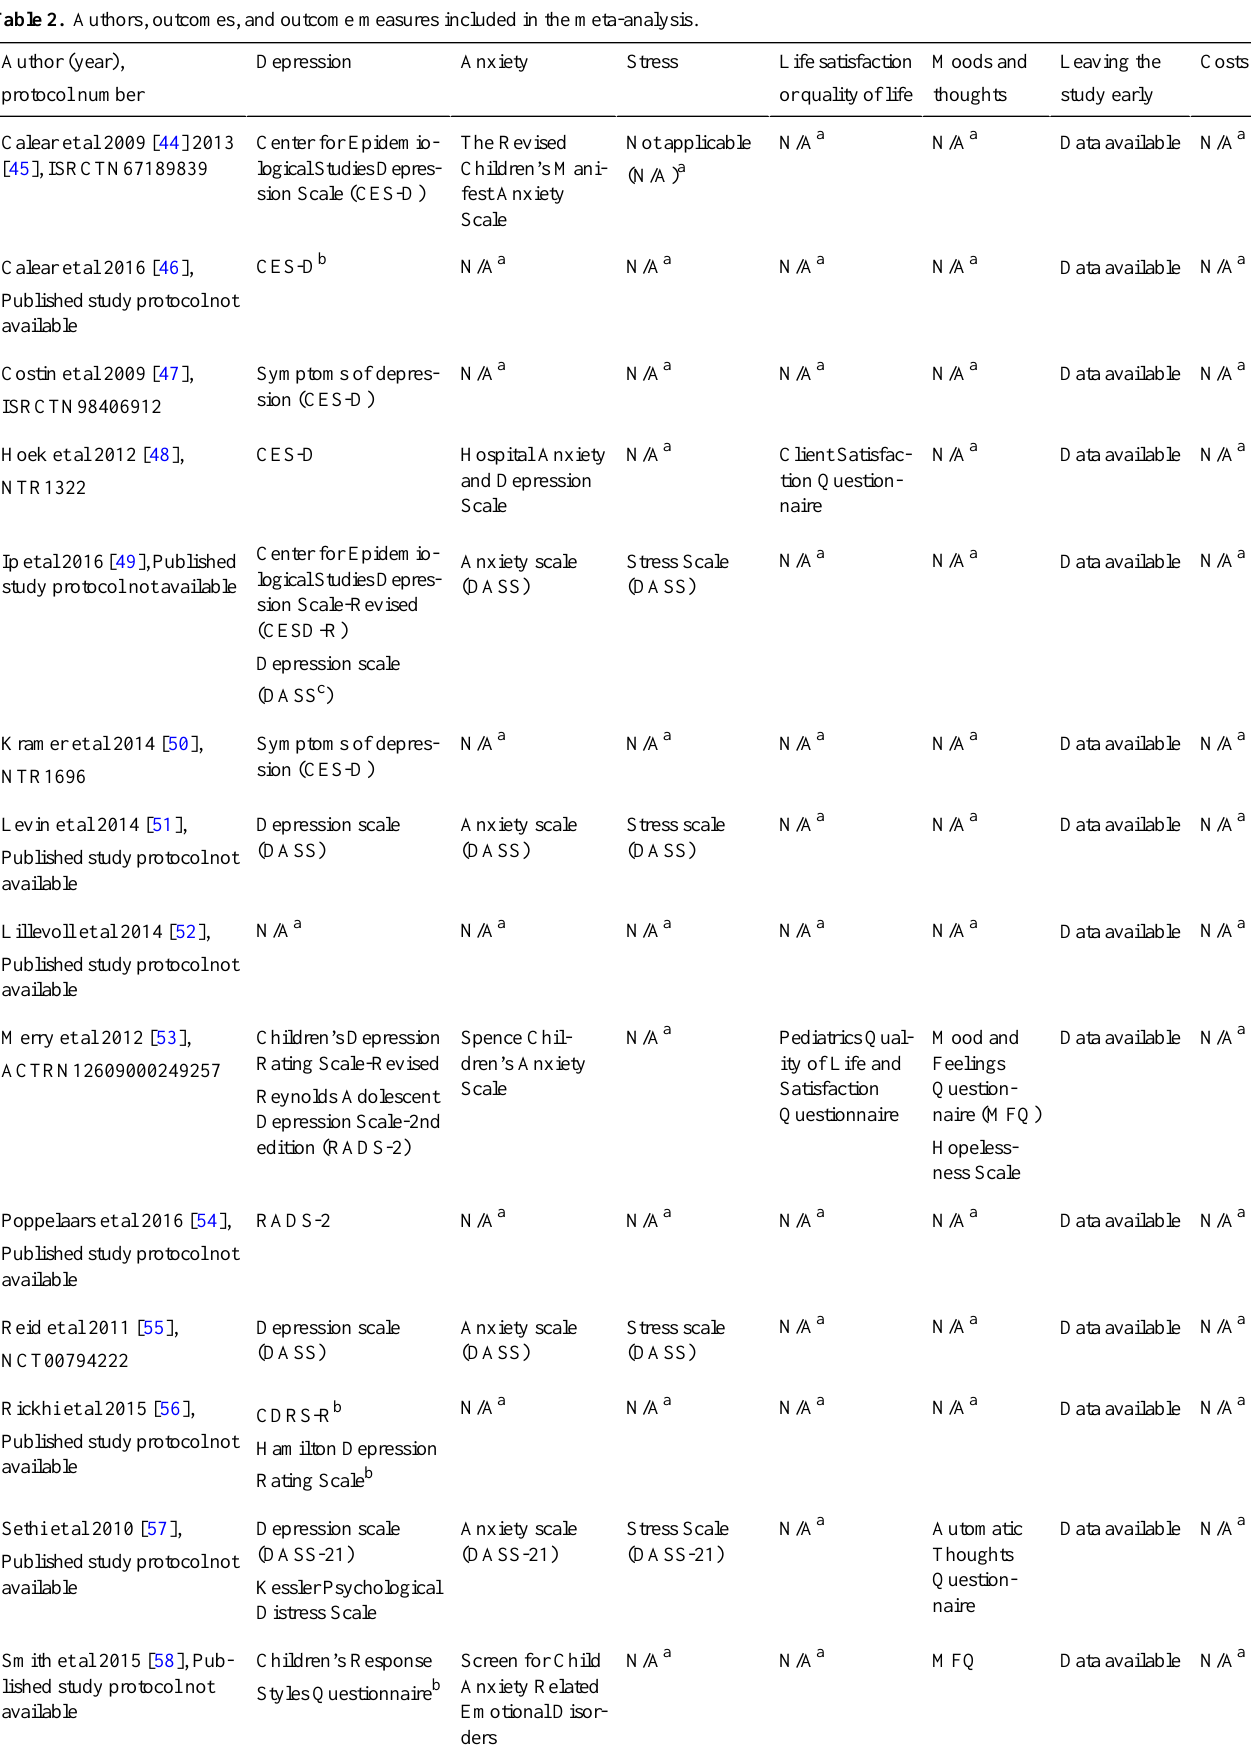
Table 2. Authors, outcomes, and outcome measures included in the meta-analysis.